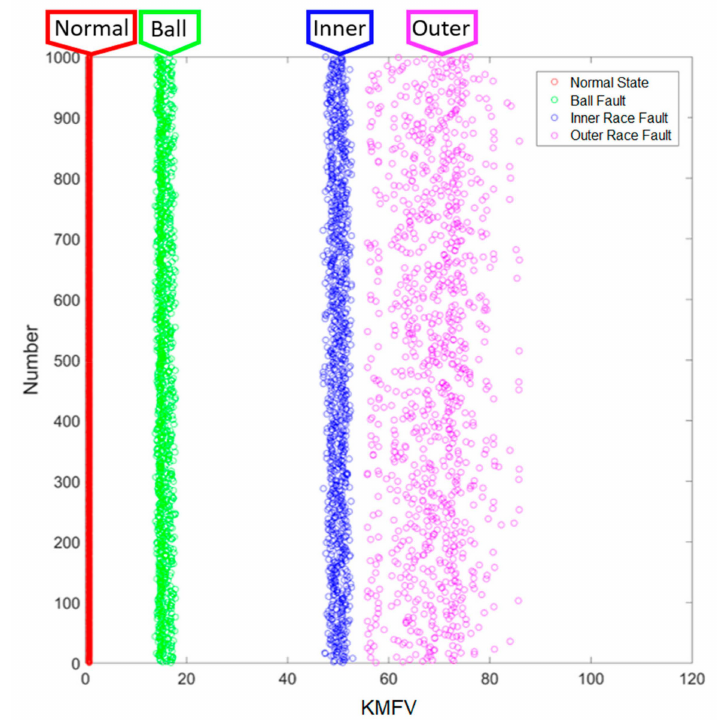
Figure 14. Smart Fault Detection Method 3.